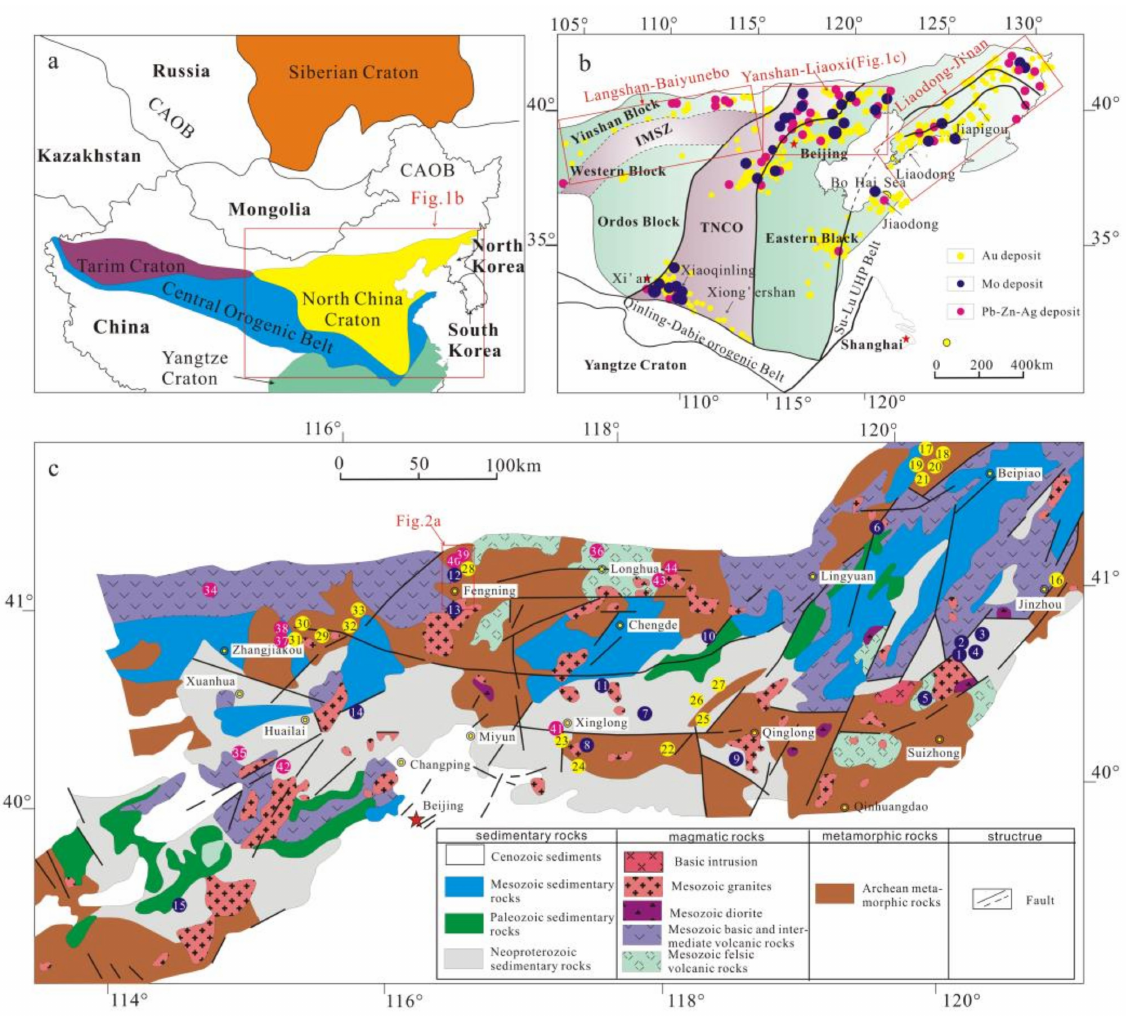
Figure 1. ( a ) Simplified tectonic map of China showing the major cratons (after [7]); ( b ) Sketch map of the NCC showing the distribution of silver-polymetallic deposits (after [3,8]). IMSZ, Inner Mongolia Suture Zone; TNCO, Trans-North China Orogen; ( c ) Distribution of the silver and polymetallic deposits in the Yanshan–Liaoxi metallogenic belt (modified from [9]). Data sources and deposit numbers are listed in Table